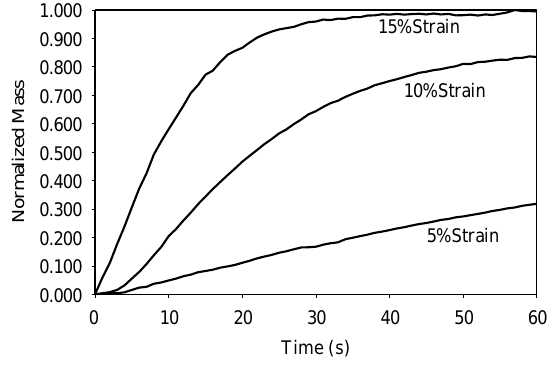
Mean (solid lines) and 95% CI (symbols) for normalized mass as a function of time (cid:4) Strain (cid:6) 10%, Cycle Speed (cid:6) 1.33 cycles/second and Bed Depth (cid:6) 2.54 cm